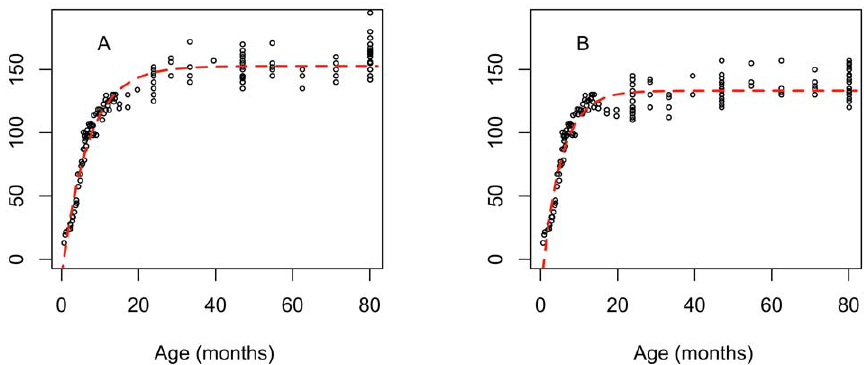
Figure 3. The life-time growth of (A) male and (B) female Tasmanian pademelons ( Thylogalebillardierii ) (black circles) and the Brody growth function (black line) fitted on the entire pes length data (pes length=a + b * (1 2 exp( 2 k * Age)).